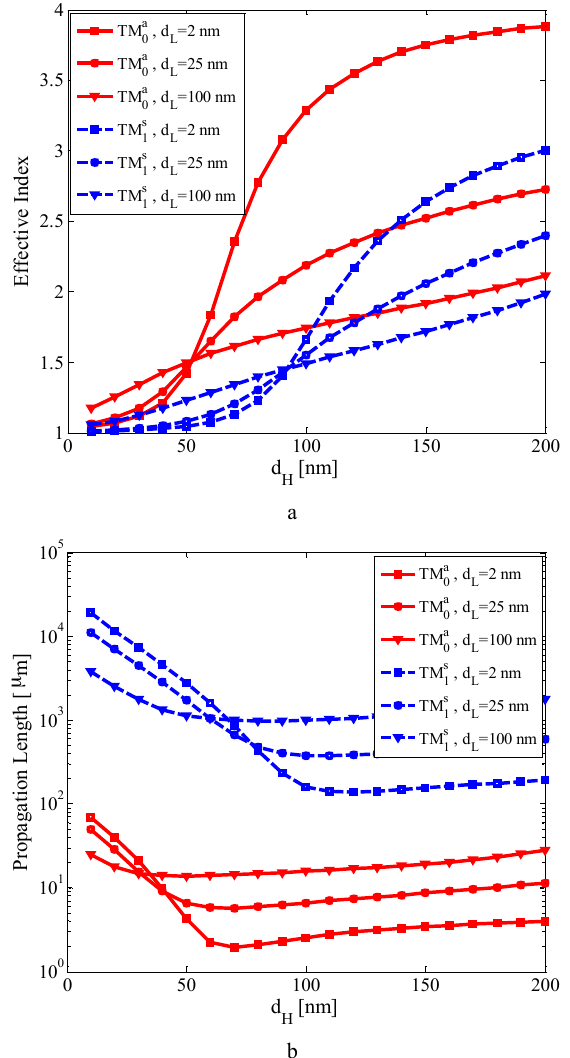
Figure 2: a. Effective refractive index and b. Propagation length, of the first two TM polarized hybrid-guided modes of the HIMI slab waveguide in terms of d H and d L . Metal thickness is chosen to be d M =20 nm. Indexes “s” and “a” stand for symmetric and anti- symmetric modes, respectively.